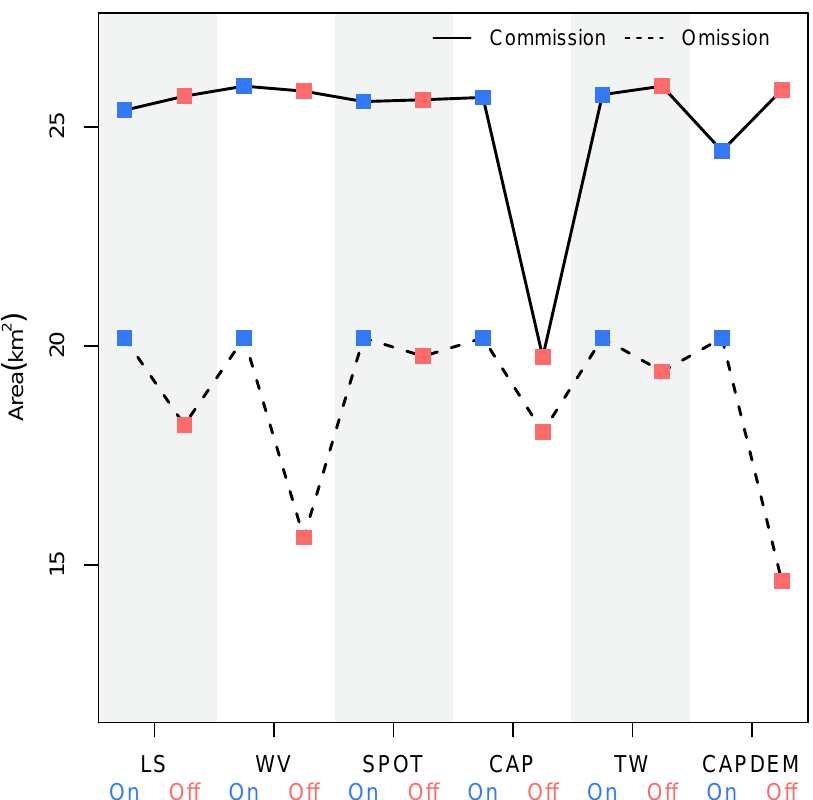
Figure 8. Depicts the contribution of each data source to the commission and omission errors. Data included in the error are represented by blue squares, while data omitted are shown using red